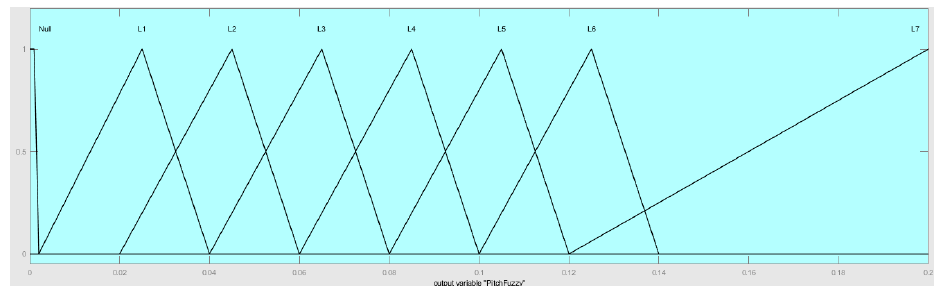
Figure 11. Membership functions of the pitch reference input. Zoom-in on the [0, 0.20] range of the horizontal axis.